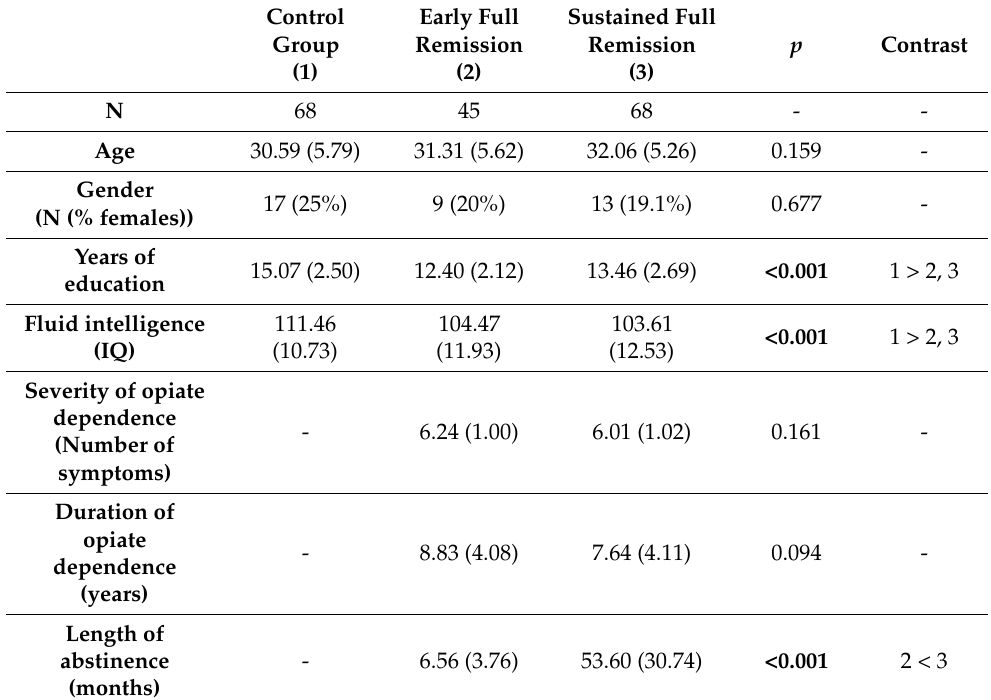
Table 1. Descriptive statistics and group differences in demographic characteristics and opiate use